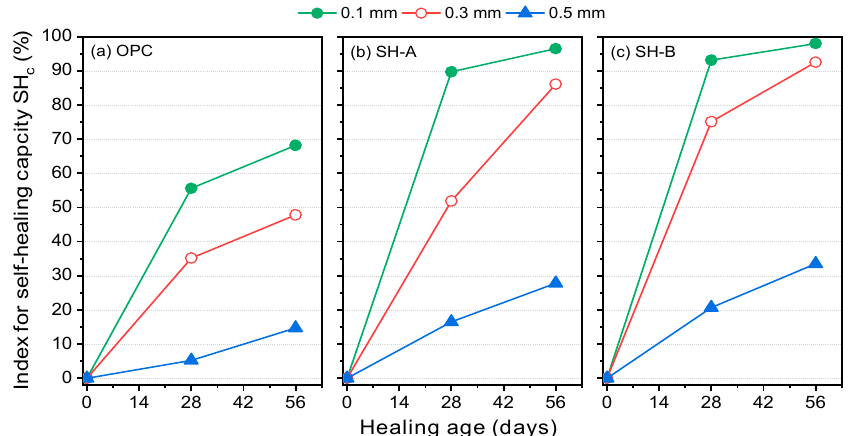
Figure 11. Indices for the self-healing capacity of different mixtures: ( a ) OPC; ( b ) SH-A; ( c ) SH-B.